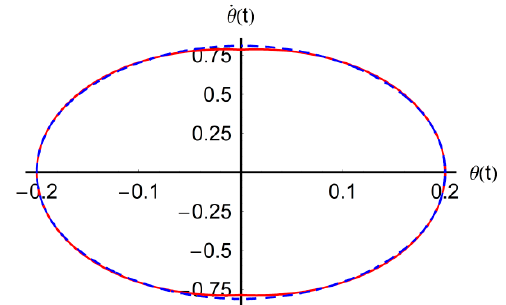
Figure 20. Comparison between the approximate solution (50) and numerical integration results for Figure 21. Phase plane for A = 0.4, L = 0.6. Figure 10. Comparison between the approximate solution (43) and numerical integration results for approximate solution. approximate solution (50).